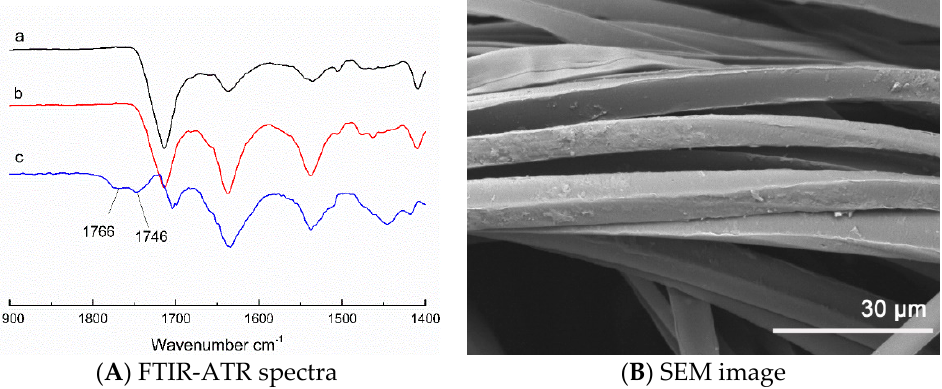
Figure 6. ( A ) FTIR-ATR spectra of the fabric after 5 recharging cycles: ( a ) pristine fabric, ( b ) after cleaning 150 tables, ( c ) difference spectrum of subtracting (a) from (b), ( B ) SEM image of the fabric after 5 recharging cycles. Table 2. The antibacterial properties and active chlorine contents after repeated chlorine recharges. Antibacterial Property Active Chlorine (ppm) Repetition Tables